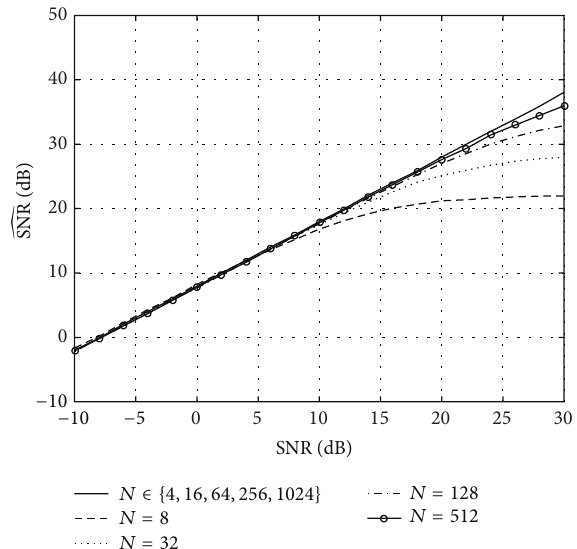
̂ SNR ( dB ) ) as a function of